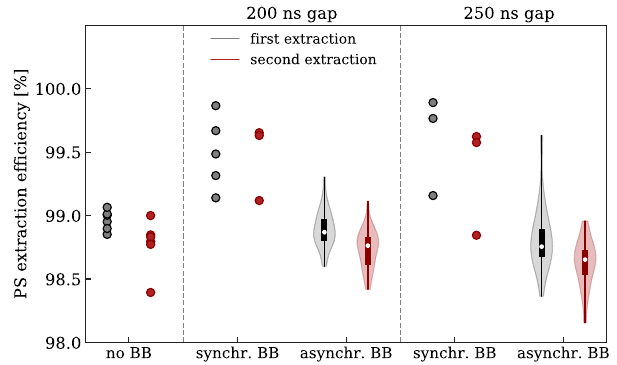
FIG. 14. Example of beam intensity in the SPS as a function of time together with the evolution of the beam momentum. The vertical lines indicate the different stages at which the relative transmission efficiencies are